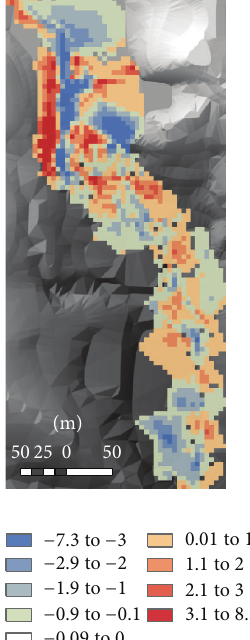
Figure 8: The evaluated values of erosion and deposition depth.